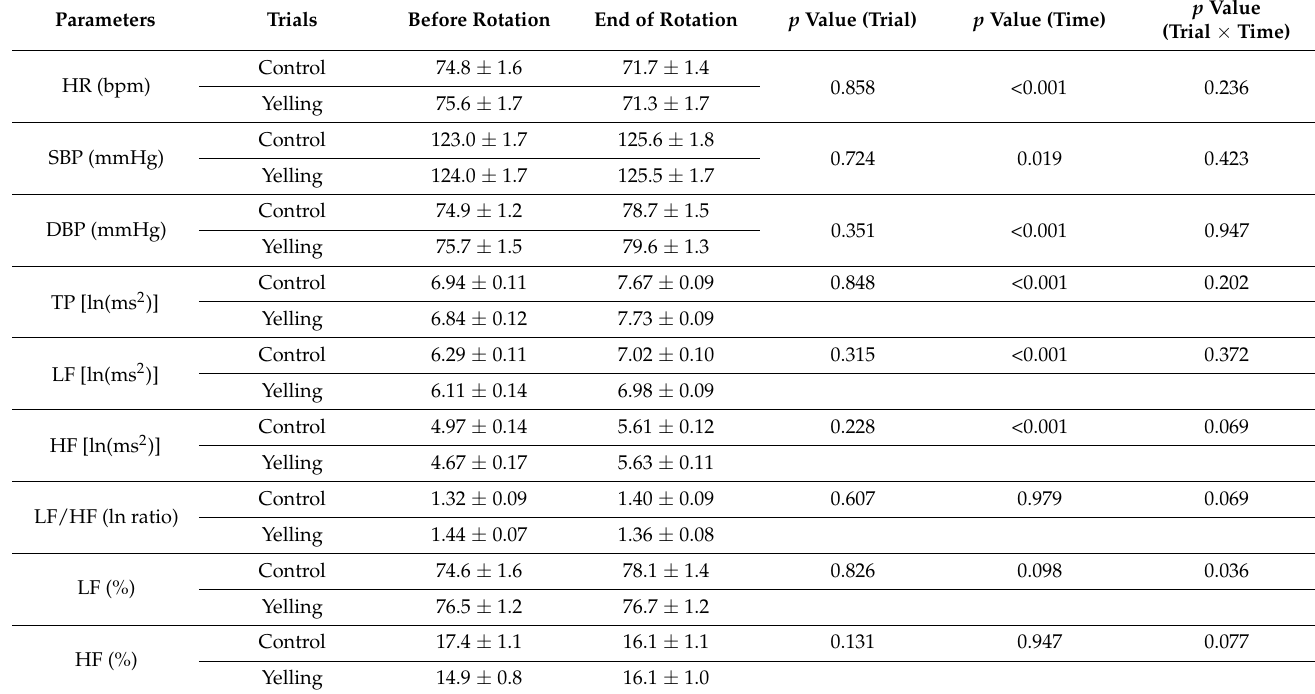
Table 3. Effects of the yelling intervention on various physiologic responses in rotation stimulation ( n = 42). Parameters Trials Table 2. Effects of simple yelling at rest on various physiologic measurements ( n = 13). Parameters